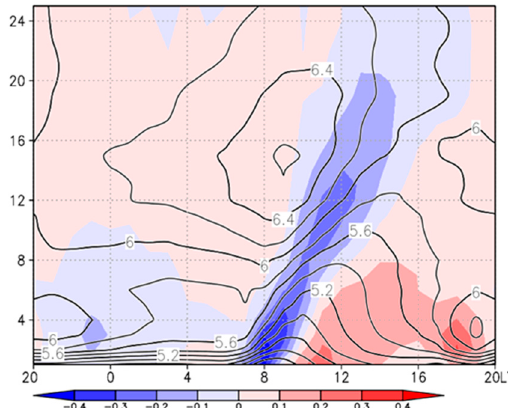
Figure 4. Vertical cross-sections of area-averaged annual means of hourly onshore wind speeds (contours; m/s) and its hourly changes (shaded) obtained from the ensemble mean. The hourly changes are computed by the previous hour subtracted from the current hour. The horizontal axis represents the local time while the vertical axis represents the height in meters.